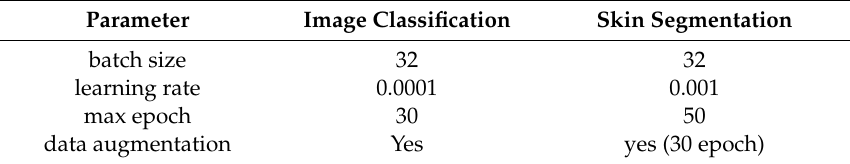
Table 2. Model training parameters used for image classification and skin